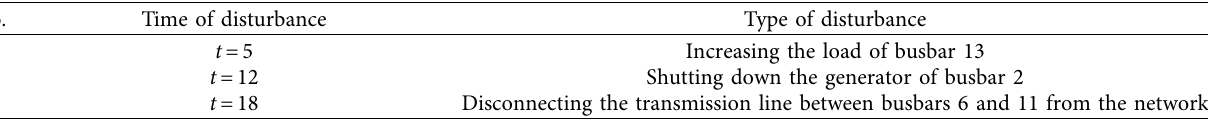
Table 4: Disturbances on the IEEE standard 14-bus network at diferent times.